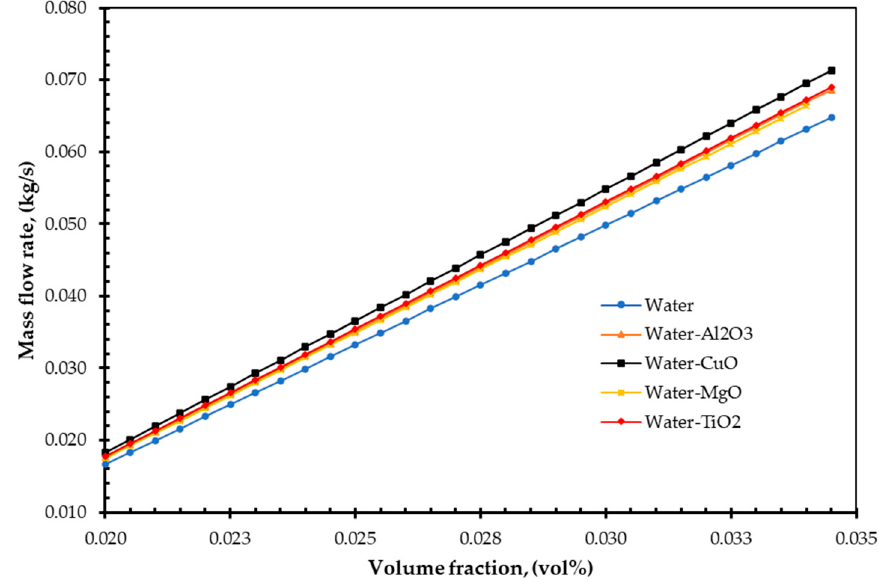
Figure 9. Effect of particle volume fraction on mass flow rate.